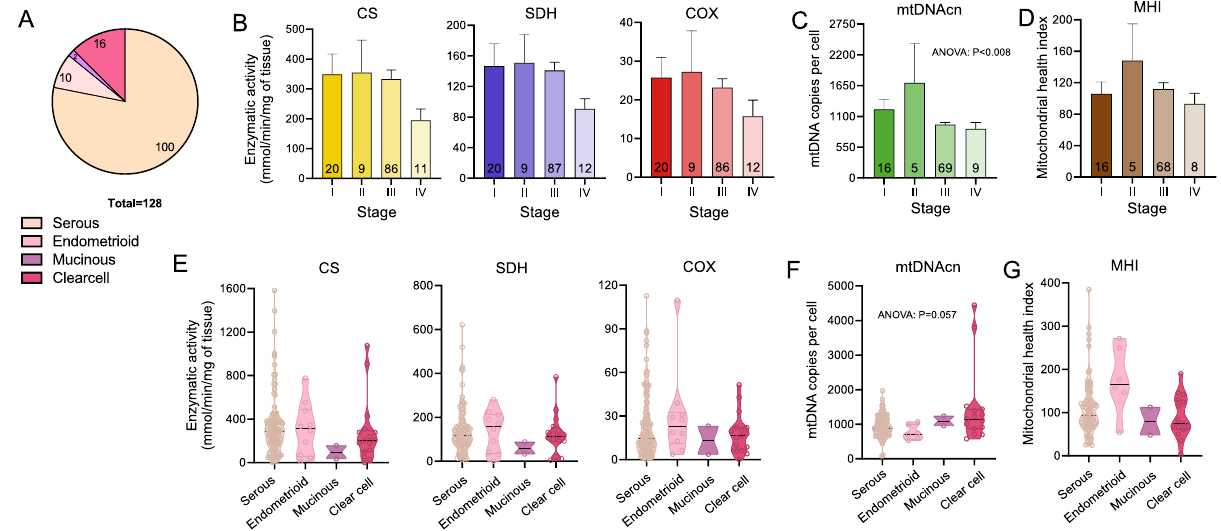
Figure 3. Mitochondrial phenotyping across EOC histologic subtypes and benign tissue. ( A ) EOC histologic subtypes included in this study. ( B ) Mitochondrial enzymatic activities, ( C ) mtDNAcn, and ( D ) MHI by tumor stage. Data are means ± SEM. ( E ) Enzymatic activities, ( F ) mtDNAcn, and ( G ) MHI values by EOC histologic subtype shown as violin plots with each datapoint representing an individual patient. P values from one-way ANOVA performed on log-transformed data. The non-transformed data is